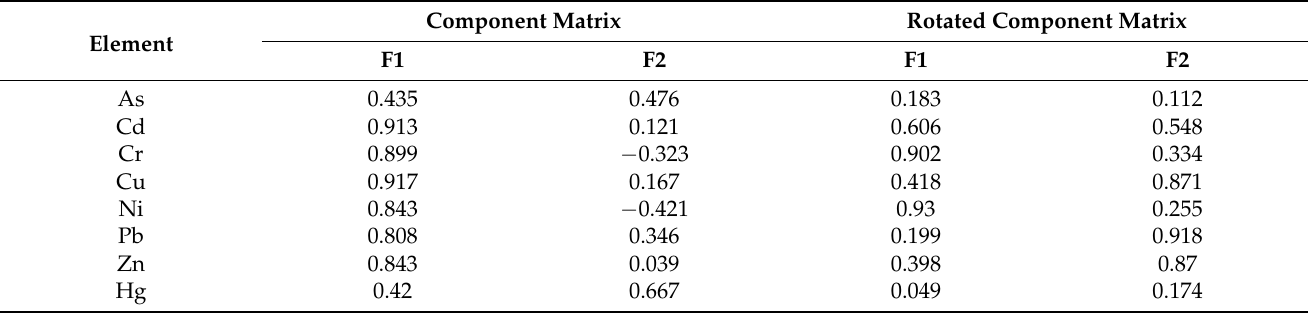
Table A3. Component and rotated component matrices for heavy metal